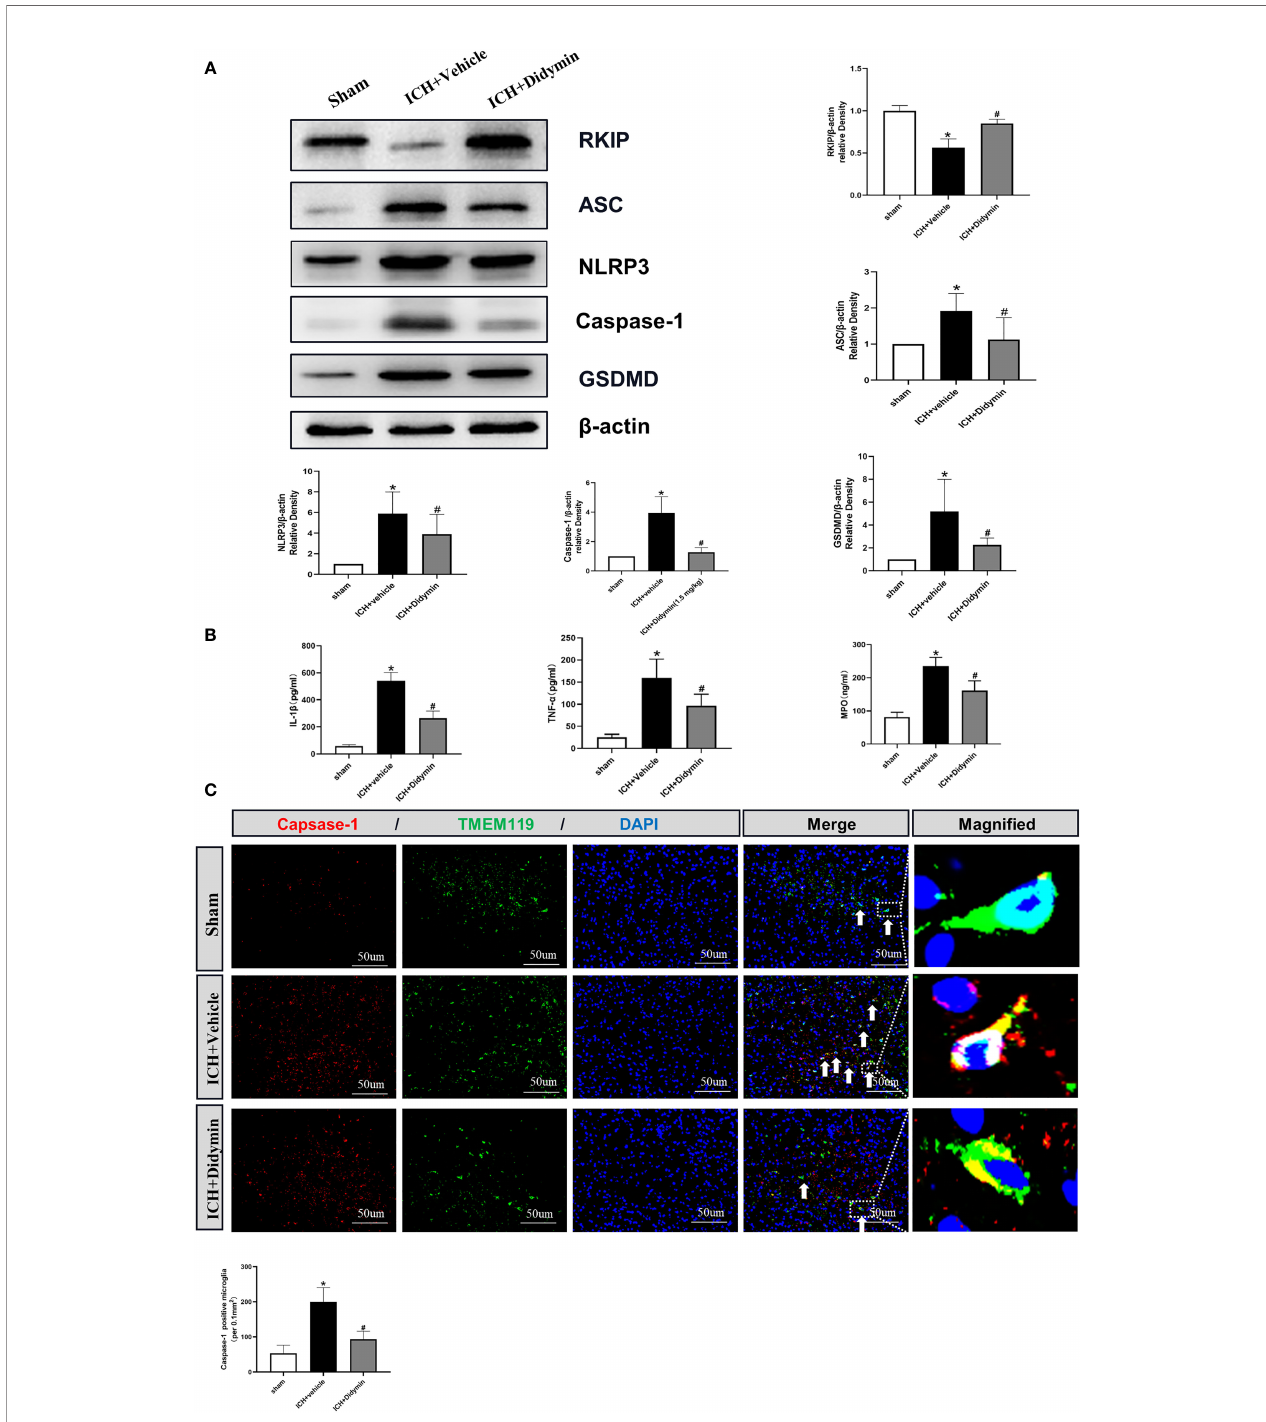
FIGURE 5 | Didymin ameliorated microglial pyroptotic molecules and in fl ammatory cytokines after ICH. (A) Representative Western blot bands and densitometric quanti fi cation of Rkip, Asc, Nlrp3, Caspase-1, and GSDMD. n = 6 for each group. * p < 0.05 vs. sham; # p < 0.05 vs. ICH+vehicle. (B) IL-1 b , TNF- a , and MPO production were detected by ELISA assay kit. n = 6 for each group. * p < 0.05 vs. sham; # p < 0.05 vs. ICH+vehicle. (C) Caspase-1/TMEM119 double immuno fl uorescence staining and quantitative analysis of Caspase-1-positive microglia. Scale bar = 50 m m. n = 3 for each group. * p < 0.05 vs. sham; # p < 0.05 vs.